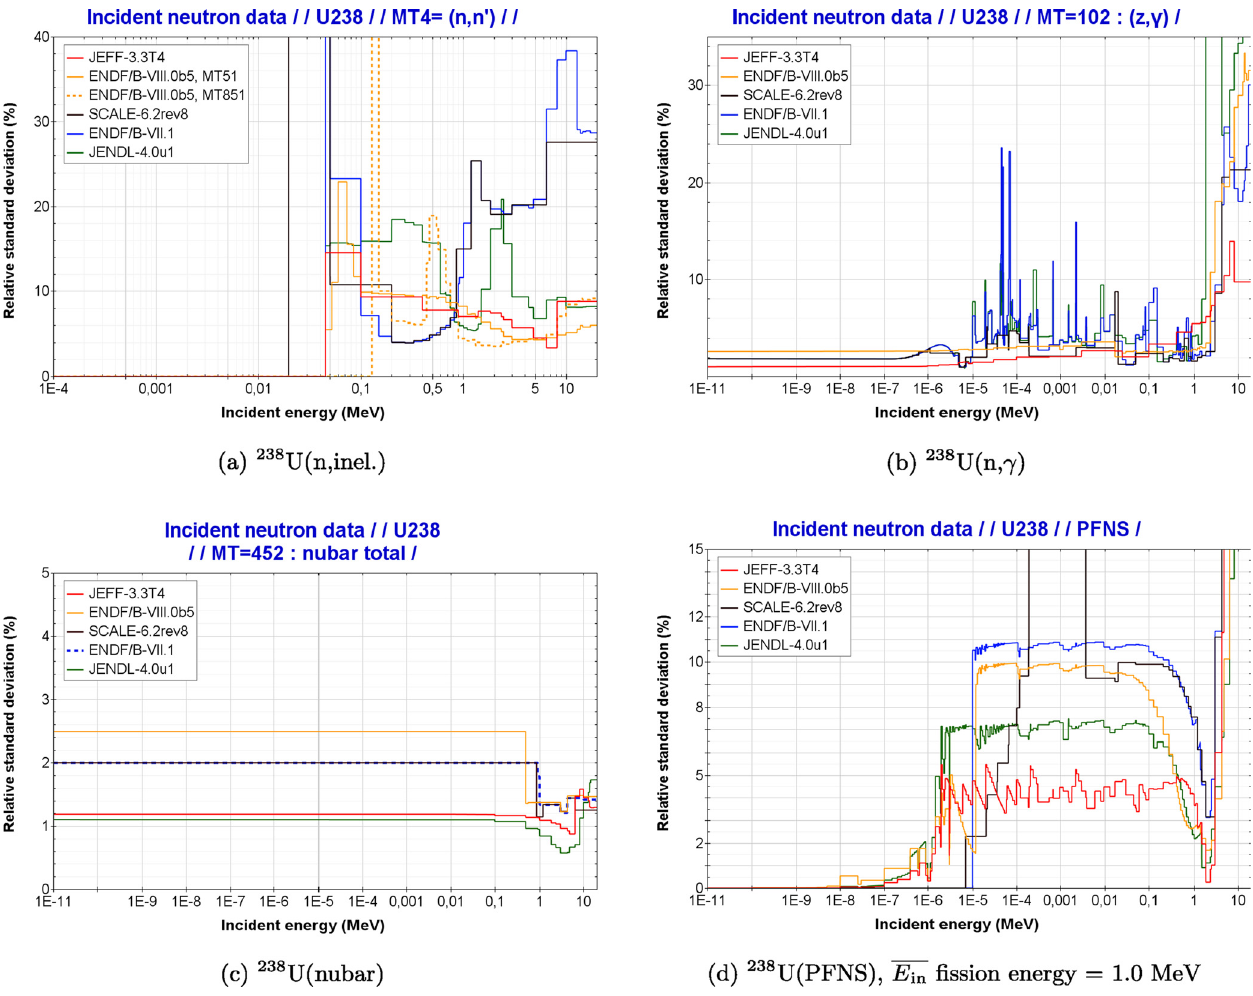
Fig. 3. Relative standard deviation (%) for 238